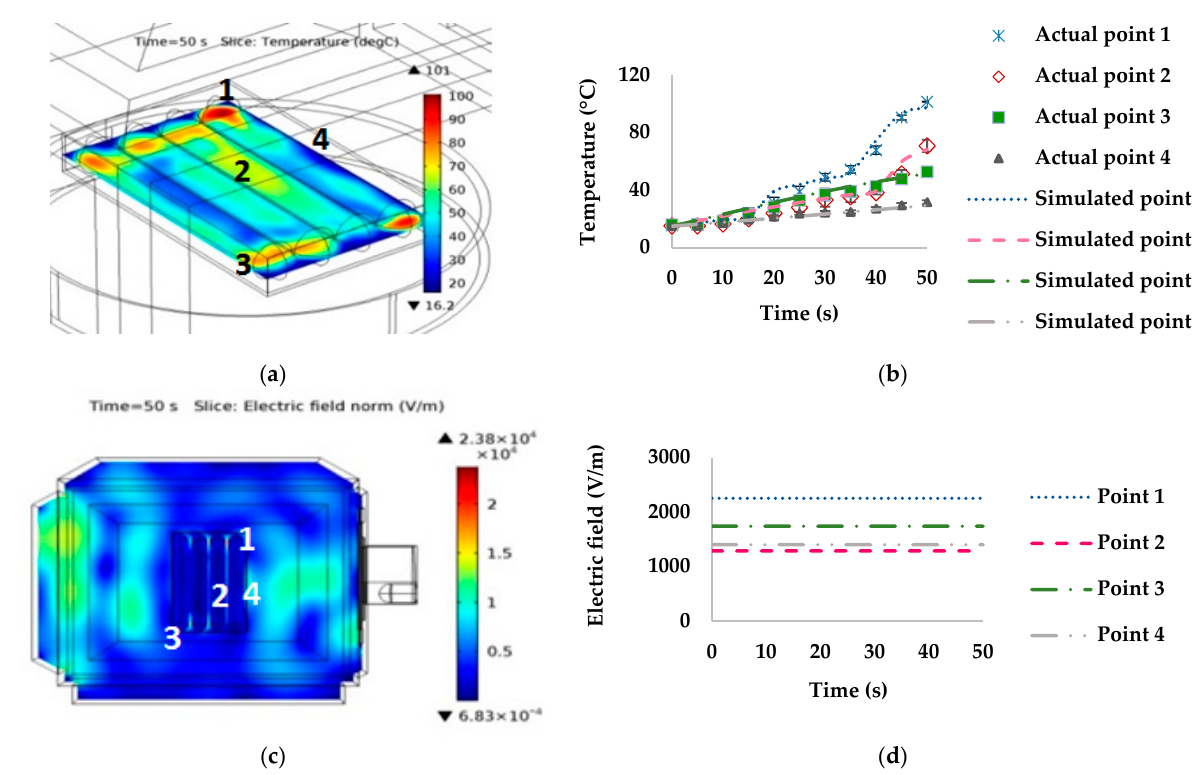
Figure 6. Effect of simulated stationary microwave on ( a ) thermal simulation, ( b ) temperature profile at points 1–4, ( c ) electric field, and ( d ) electric field profiles at points 1–4 of ready-to-eat sausage at 0° orientation to waveguide.